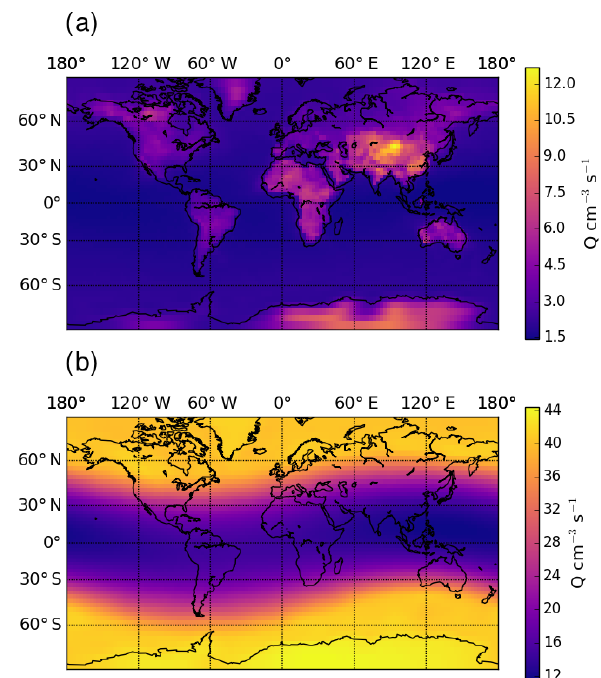
Figure 4. Global distribution of yearly mean ion pair production rate, Q , at ground level (a) and at 200hPa (b)